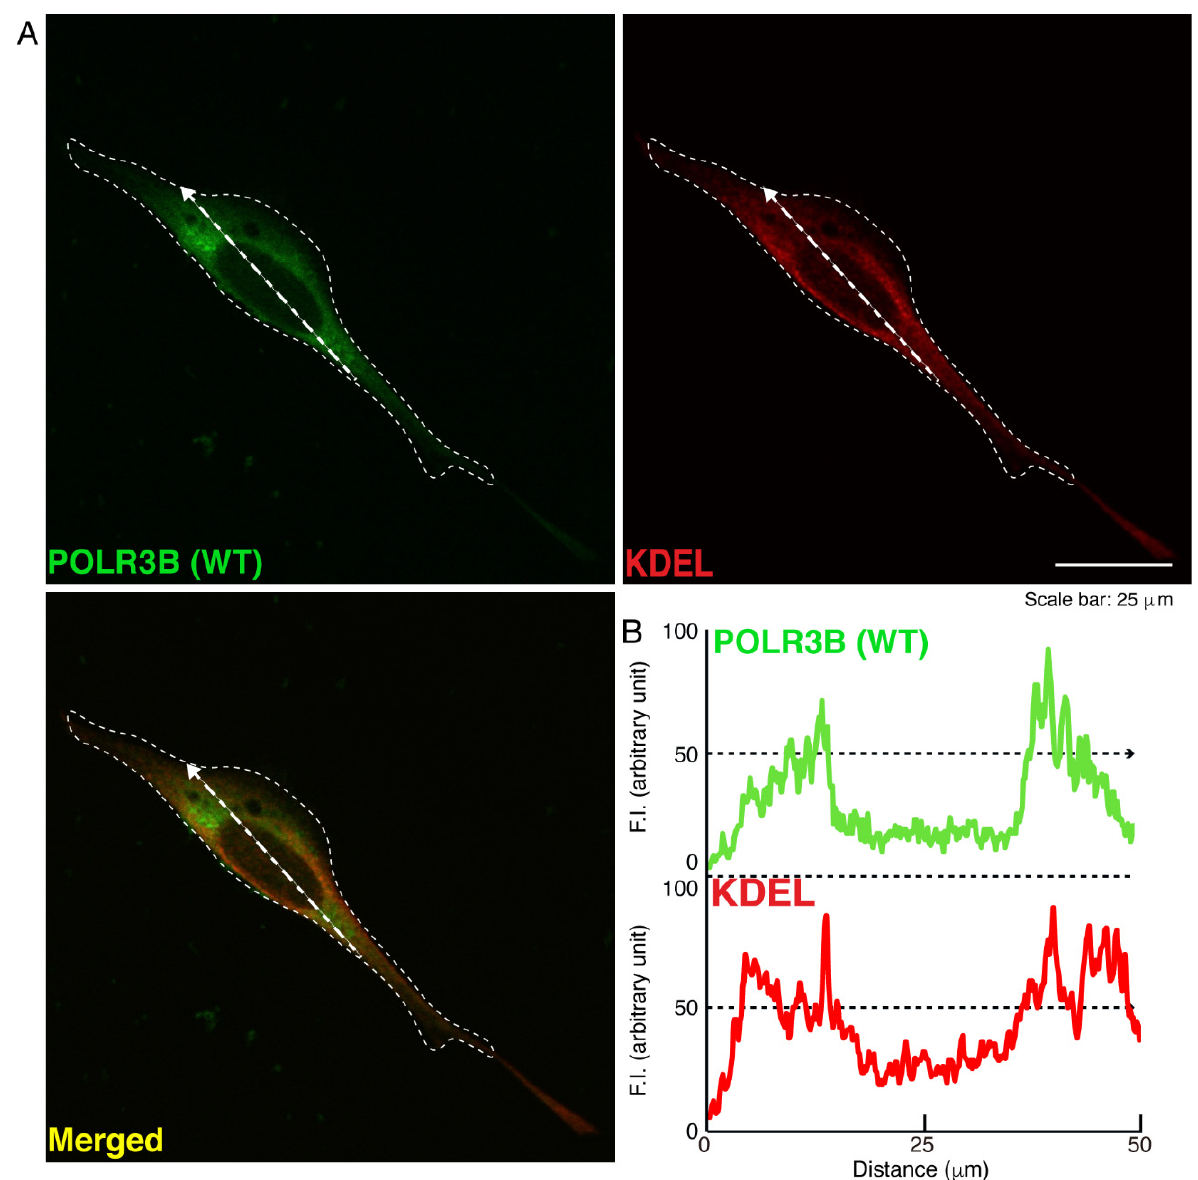
dotted lines in the direction of the arrows can be seen in the bottom panels. ( C ) Percentages of cells with punctate structures were statistically assessed (** p < 0.01; n = 3 fields).